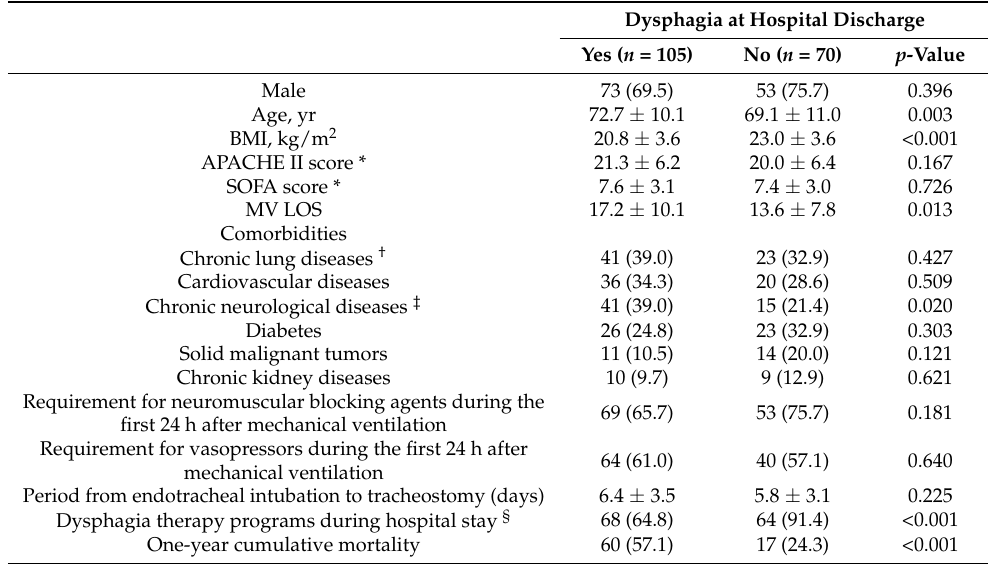
Table 2. Clinical characteristics of patients with and without dysphagia at hospital discharge.